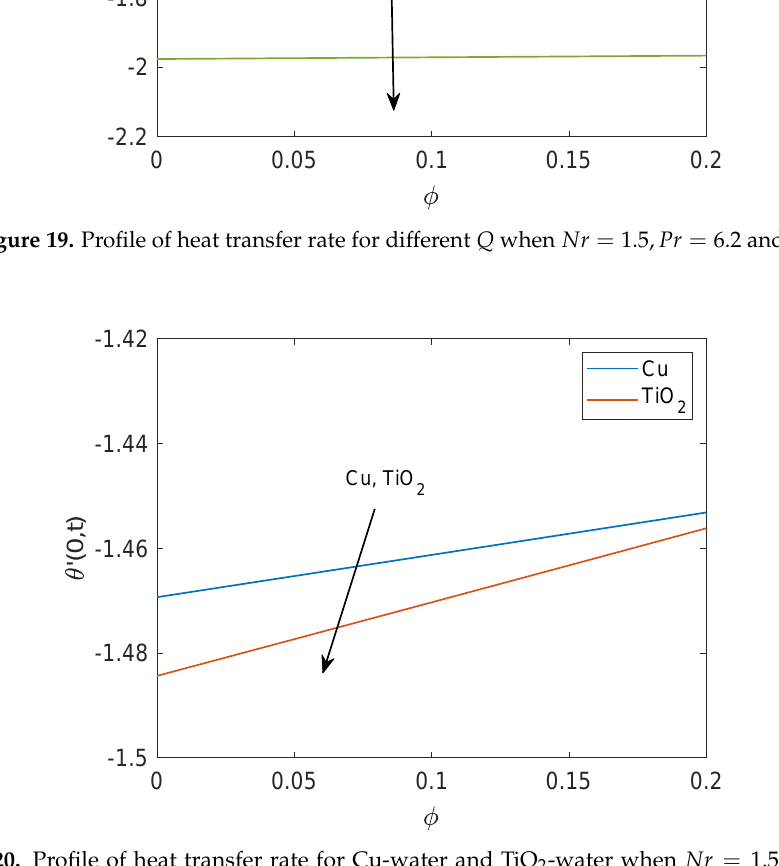
Figure 20. Profile of heat transfer rate for Cu-water and TiO 2 -water when Nr = 1.5, Q = 0.5 and t =